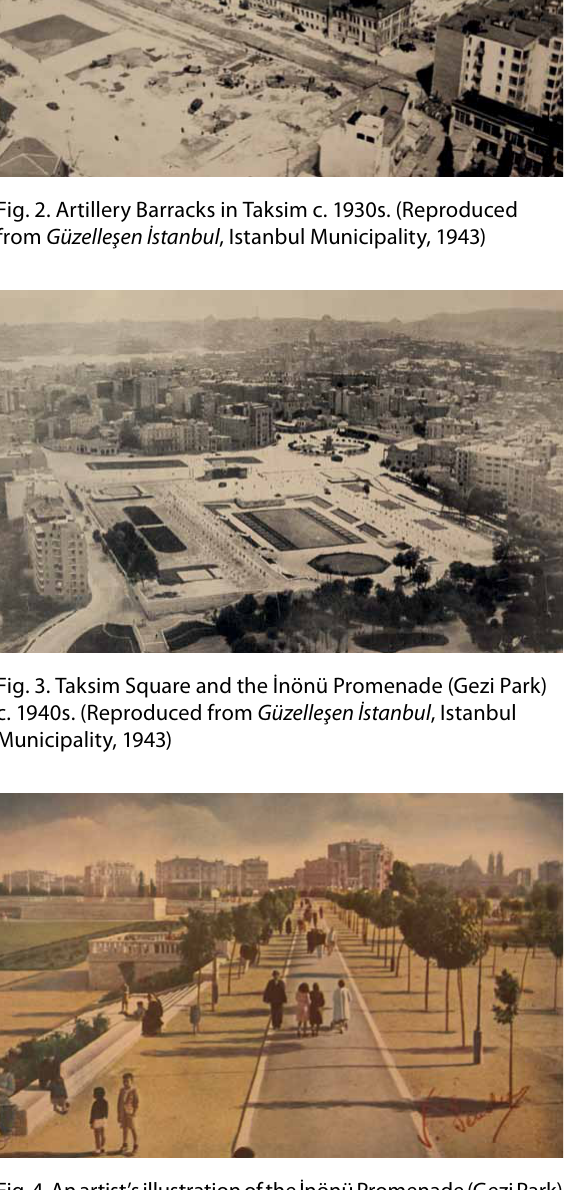
fig. 4. an artist’s illustration of the İnönü Promenade (Gezi Park) in a municipality’s propaganda book c.1940s. (reproduced